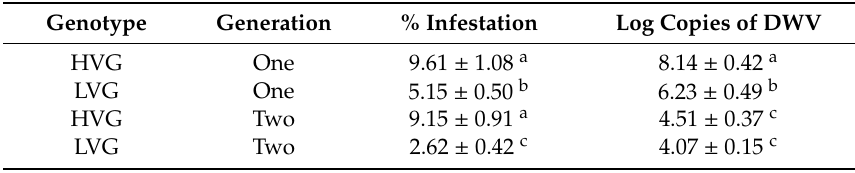
Table 1. Percent adult bee infestation with V. destructor ( ± SE) and mean log copies. of deformed wing virus (DWV) ( ± SE) found in HVG and LVG colonies after two generations of selection. Di ff erent letters after means and SE, indicate significant di ff erences between